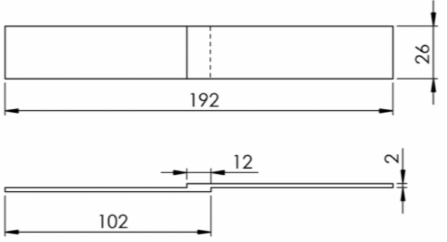
Figure 1. Specimen geometry used for single-lap joints.